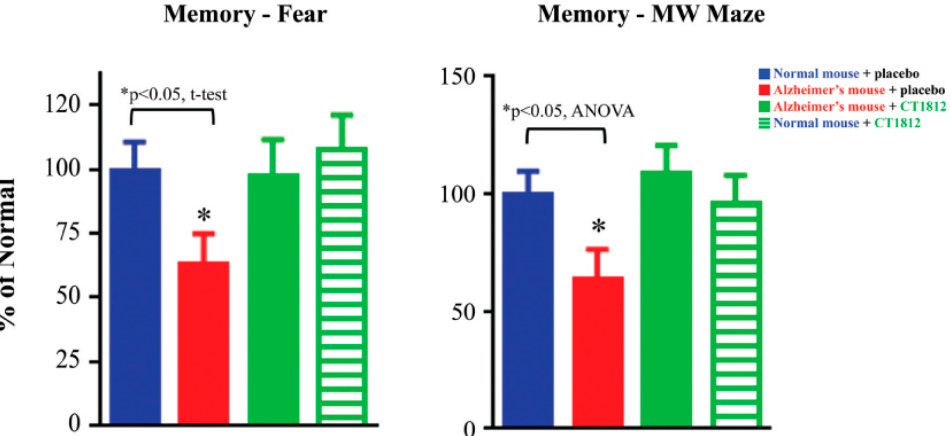
Figure 5. S2R modulator CT1812 restores functional capabilities in a mouse model of Alzheimer’s disease. Transgenic mice exhibiting phenotypes associated with Alzheimer’s disease (red bars) performed significantly worse in both the fear trigger recall test and Morris water (MW) maze tests when compared with normal, non-transgenic mice (blue bars). After administration of CT1812, however, the Alzheimer model mice (green bars) performed similar to that of wild-type mice. These results are illustrative of the restorative effects of CT1812 on synaptic proteins and the animal’s functional capabilities. Adapted from Ref. [64], 2021, Izzo, et al.